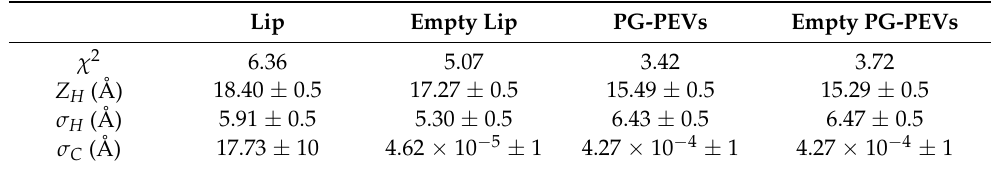
Table 7. Fitting parameters and derived parameters ( ± estimated error from the fit) for SAXS curves of empty and P. spinosa nanoformulations.